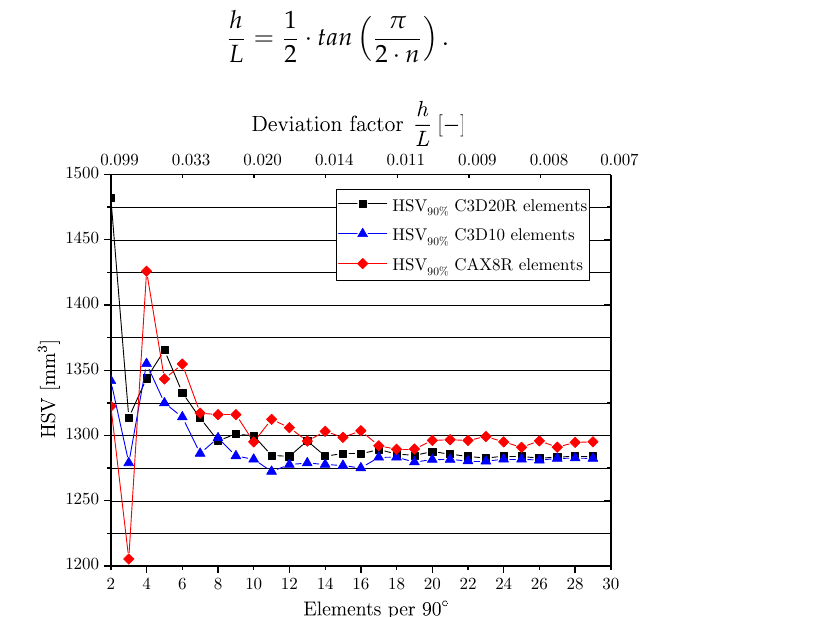
Figure 4. Effect of element seed on numerically determined highly-stressed volume